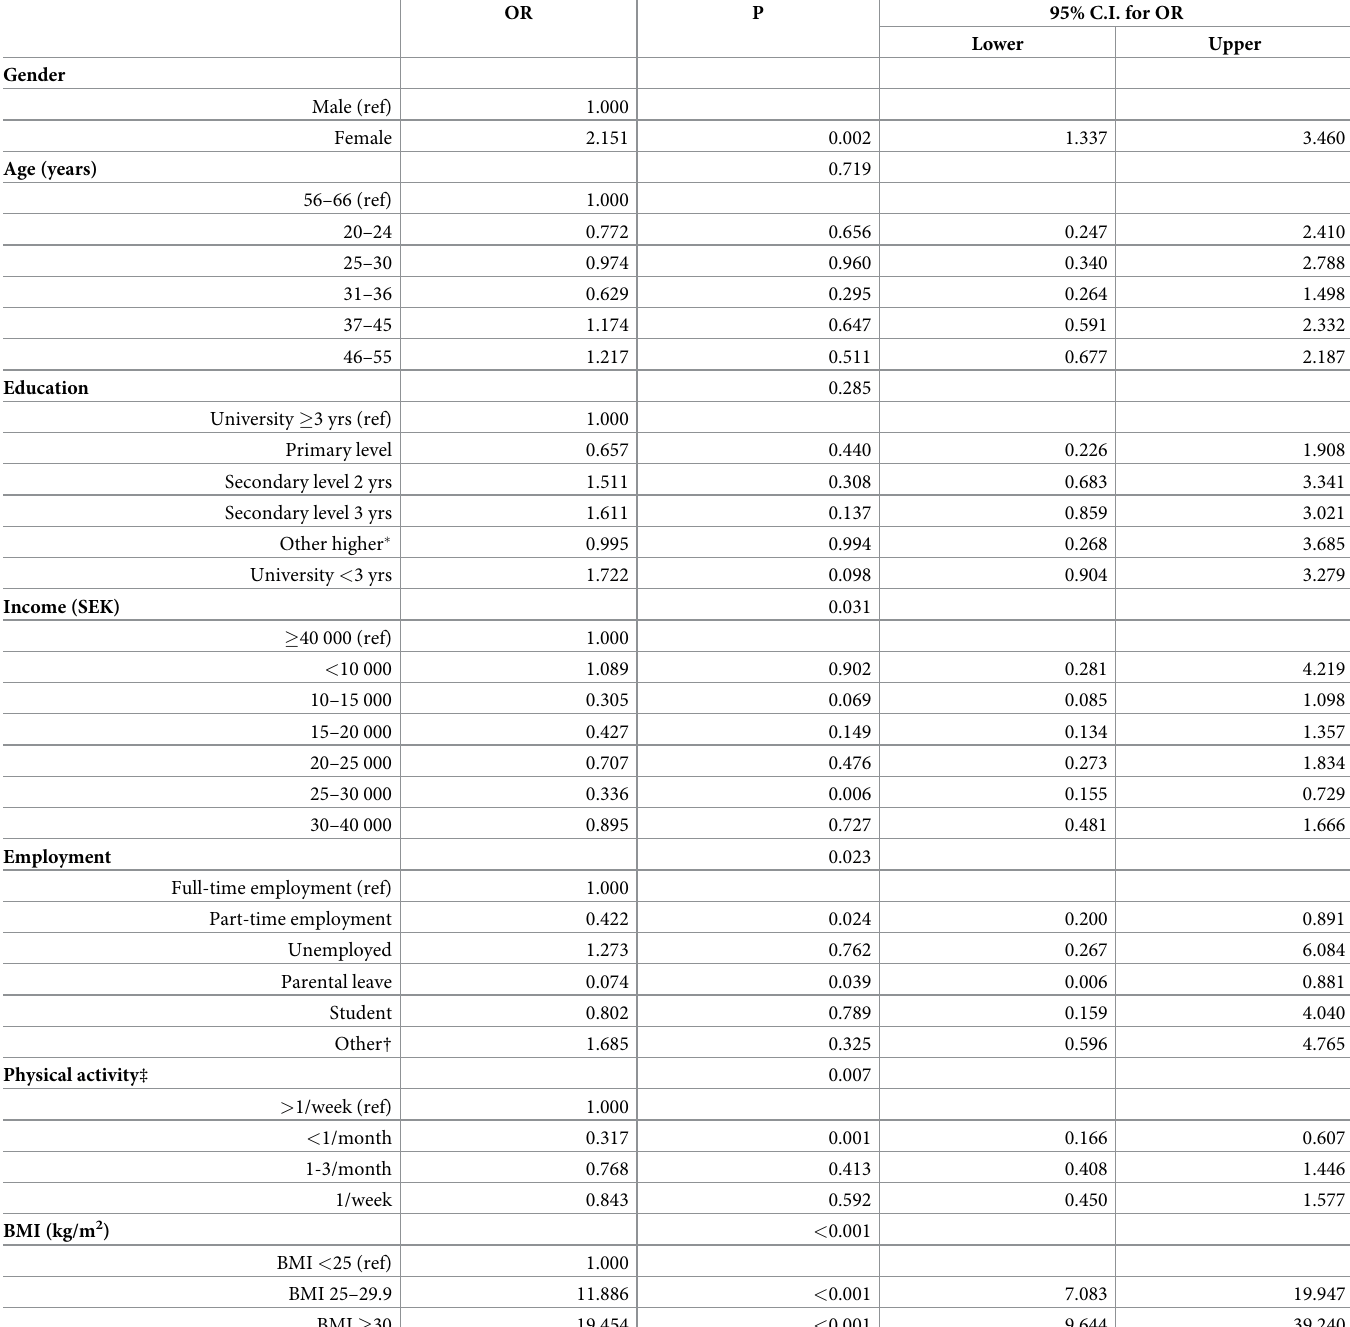
Table 2. Determinants of actively trying to lose weight in multivariable logistic regression analysis (N = 555).